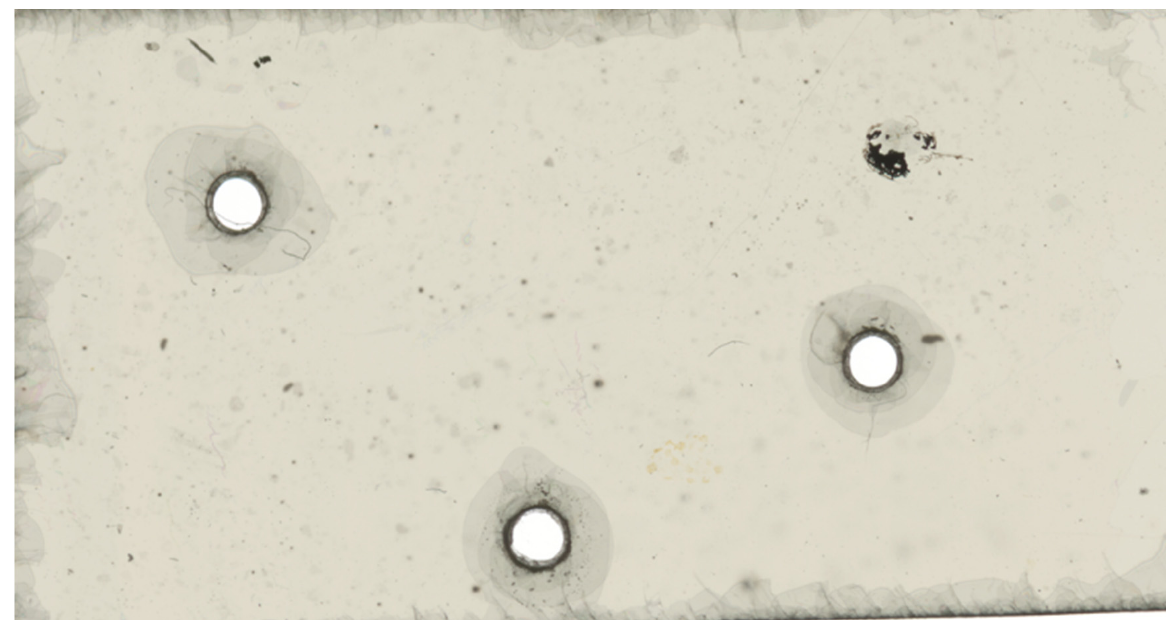
Figure 11. Fission-track mica image of GJAST − 14 − 19 (total digestion uranium concentration of 2.60 mg/kg). Shown as a background comparison. White circles are drill holes used to align the fission-tracked mica and the thin section. Length is 40 mm.